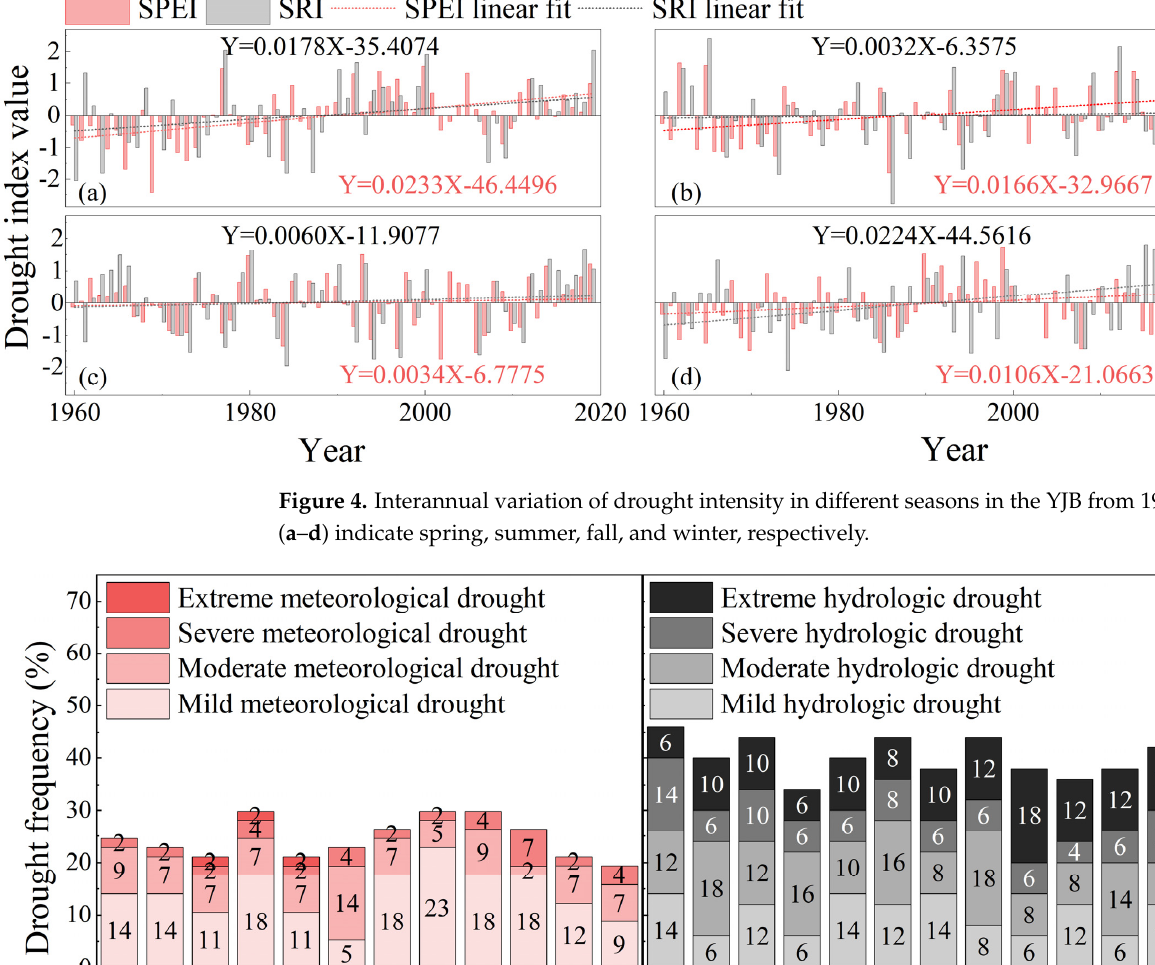
Figure 3. Drought frequency in different seasons in the YLB from 1960 to 2019; ( a – d ) indicate mete- orological drought, while ( e – h ) indicate hydrological drought; spring ( a , e ), summer ( b , f ), autumn ( c , g ), and winter ( d , h ).